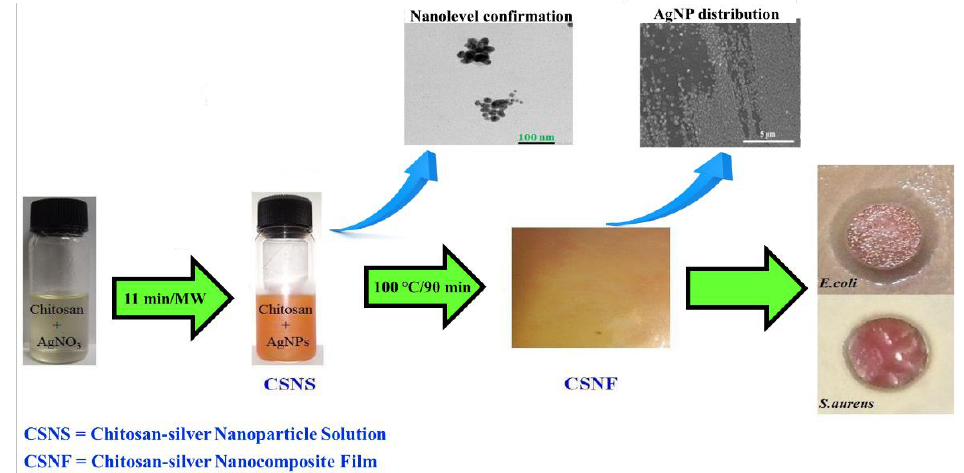
Figure 7. Pictorial illustration of green fabrication of chitosan–silver nanocomposite films (CSNFs) and their antibacterial efficiency. Reprinted with permission from Ref. [107]. Copyright 2016, copy- right with permission from Jung and Raghavendra.